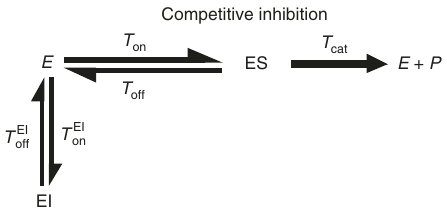
Fig. 2 A non-Markovian reaction scheme can replace in fi nitely many Markovian ones. Kinetic intermediates and multiple reaction pathways